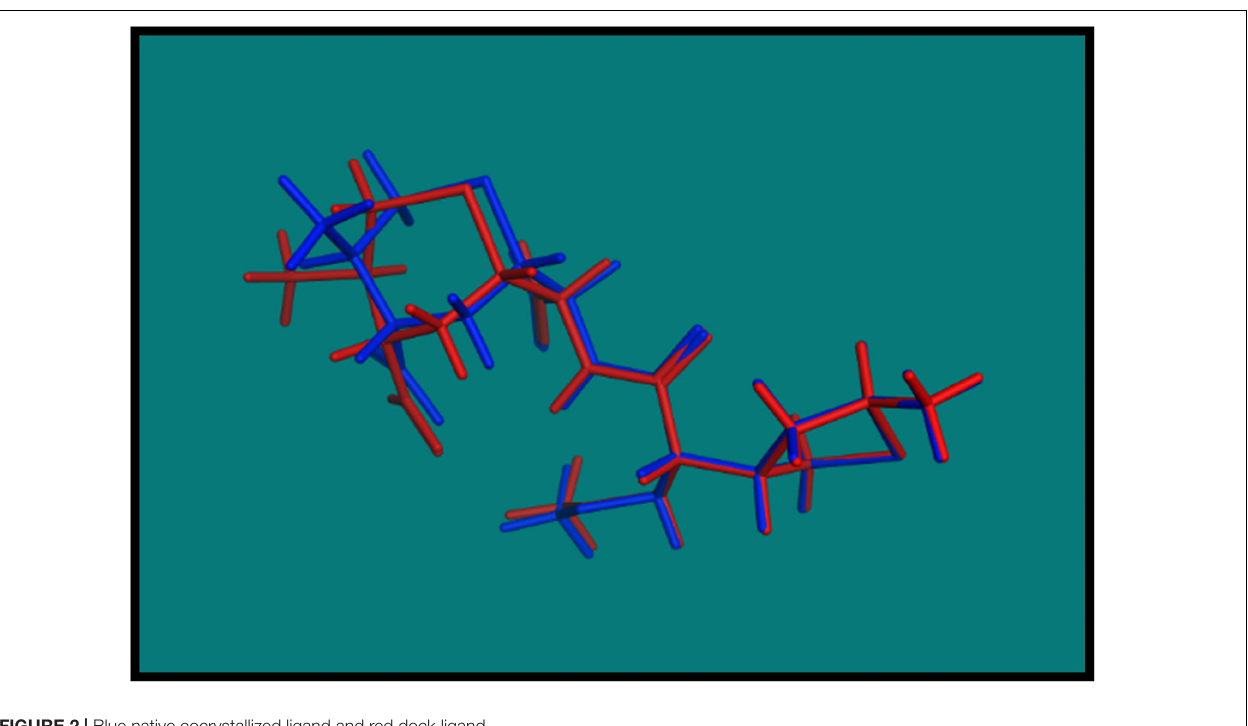
FIGURE 2 | Blue native cocrystallized ligand and red dock ligand. TABLE 5 | 16S rRNA methyltransferase B and its interaction profile with docked compounds, their ZINC ID, minimized energy, number of interactions, dock score, and interacting